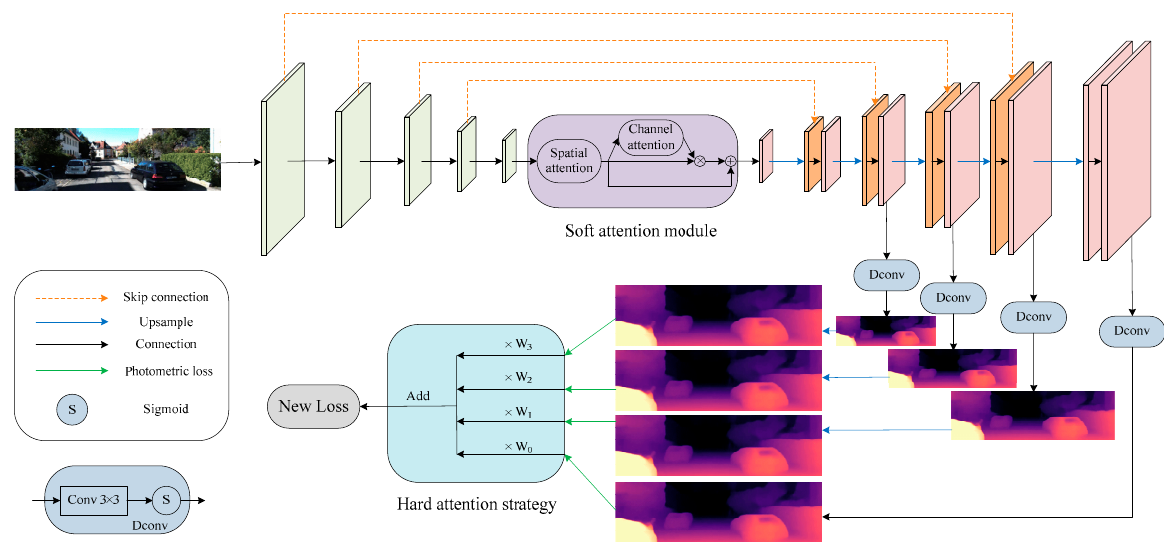
Figure 2. Overall architecture. Our depth network is based on a standard U-Net composed of a ResNet encoder and a depth decoder. Our soft attention module is integrated between the encoder and the decoder. We also use skip connection between encoding layers and associated decoding layers. The depth is decoded by our Dconv block, which consists of a 3 × 3 convolution and a sigmoid function. Furthermore, our hard attention strategy is employed after computing multi-scale photometric losses during training.